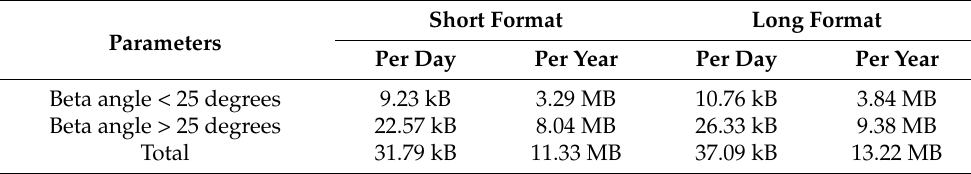
Table 9. Summary of SIoT data capacity estimation for one year including efficiency factor.